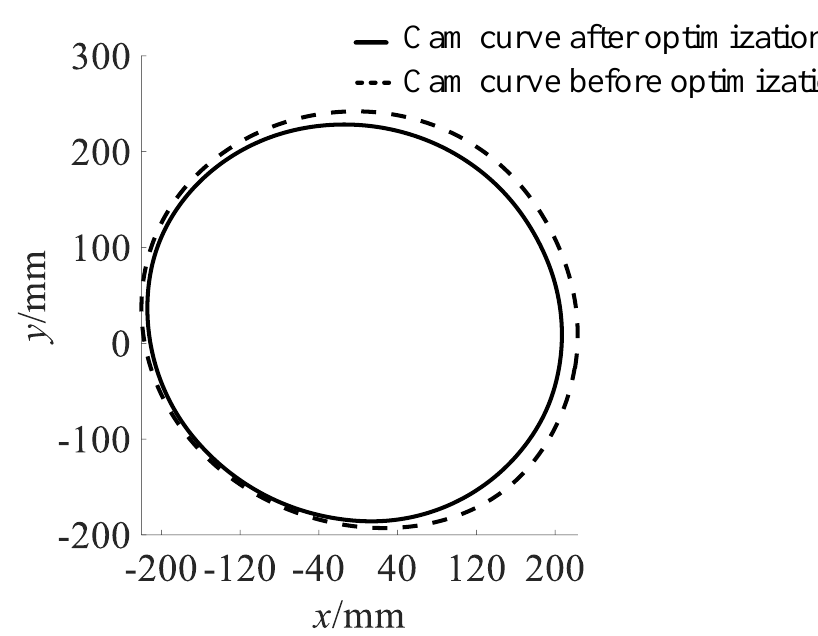
Figure 19. Comparison before and after cam